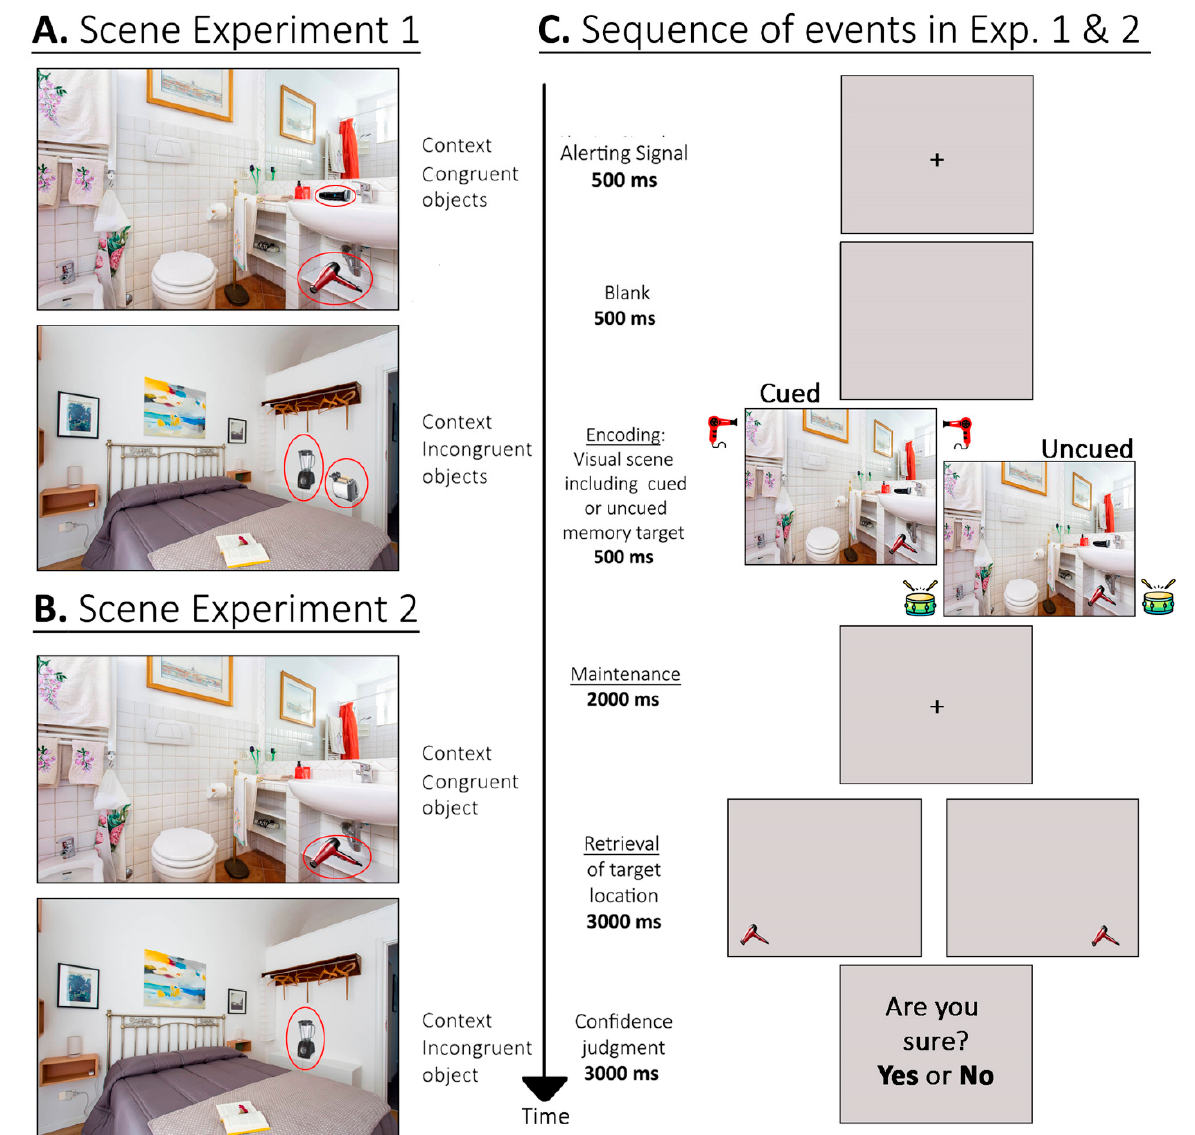
Figure 1. ( A ) Examples of the kinds of visual scene used in Experiment 1, involving either the inclusion of two contextually congruent objects (top panel) or two contextually incongruent objects (bottom panel). ( B ) Examples of visual scenes used in Experiment 2, involving either the inclusion of one contextually congruent object (top panel) or one contextually incongruent object (bottom panel). ( C ) Sequence of events in both experiments: each trial started with an alerting signal represented by a central fixation cross for 500 ms. After a blank screen for a further 500 ms, the visual scene was presented for 500 ms, together with an object sound that could cue an object in the scene or not. After a maintenance interval of 2000 ms, a single object was presented at retrieval, in the same or in a different spatial location, as compared to the original scene. The participants had to make a same vs. different object location judgment within 3000 ms and then provide a confidence judgment (yes/no) related to their previous response, again within a further time window of 3000 ms.